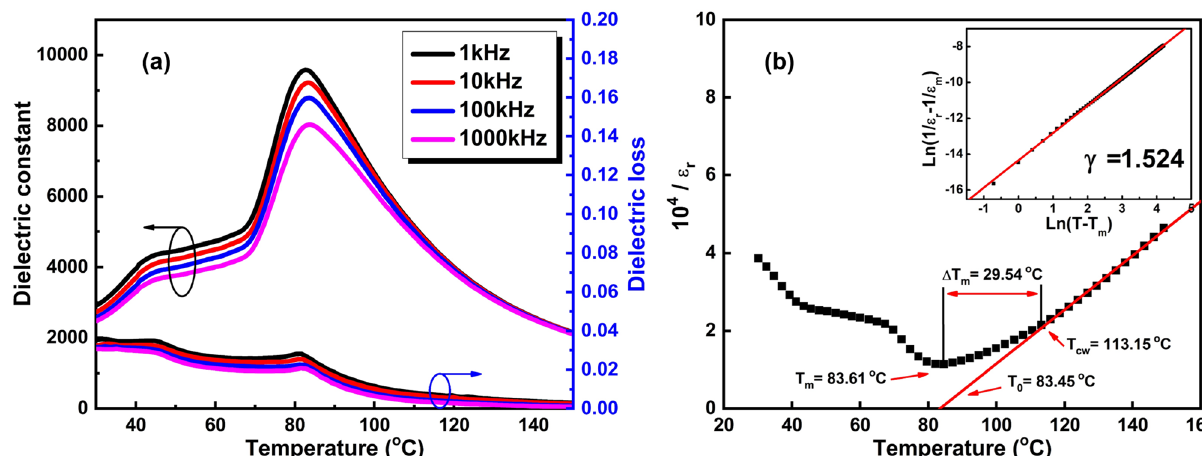
Figure 8. ( a ) Temperature-dependence of dielectric constant and dielectric loss for MSGH-derived BCZT ceramic sintered at 1400 °C, and ( b ) Curie–Weiss fitting curves of MSGH-derived BCZT ceramic sintered at 1400 °C [The inset is plot of ln(T − T m ) vs. ln(1/ε r − 1/ε m